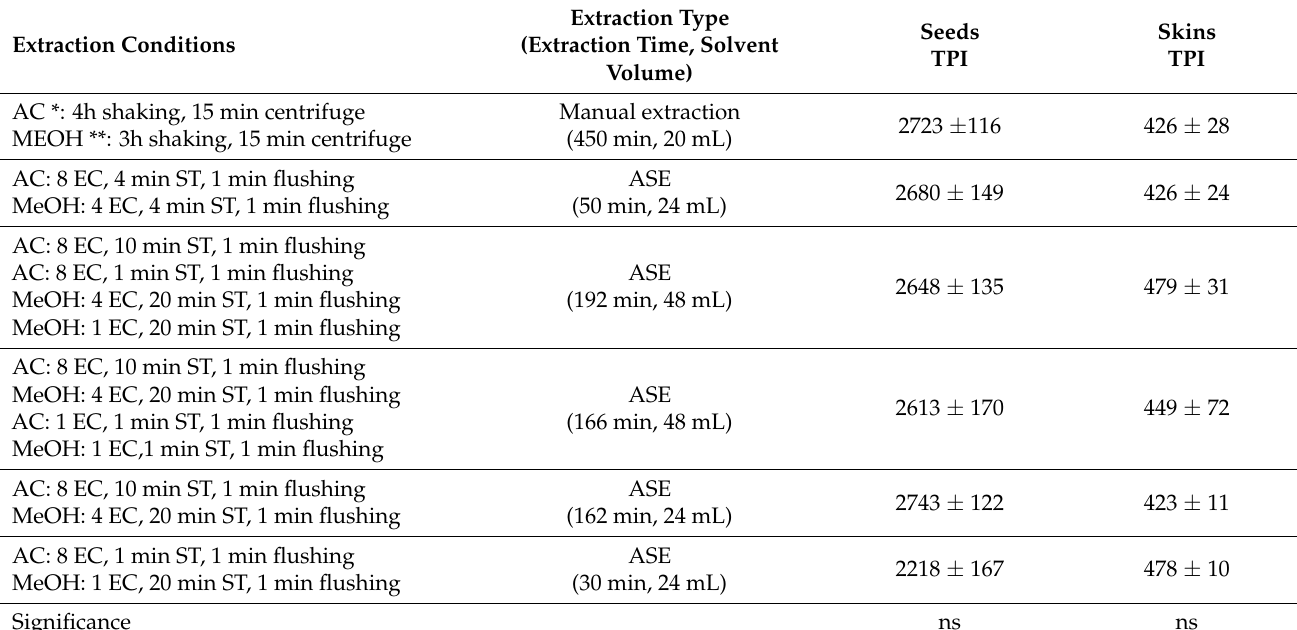
Table 3. Determination of total phenolic index (TPI) in 1 g of lyophilised grape seed and skin powder extracted with manual solid–liquid extraction and accelerated solvent extraction (ASE) at 10.3 MPa and room temperature. The results represent means ± standard deviation of four